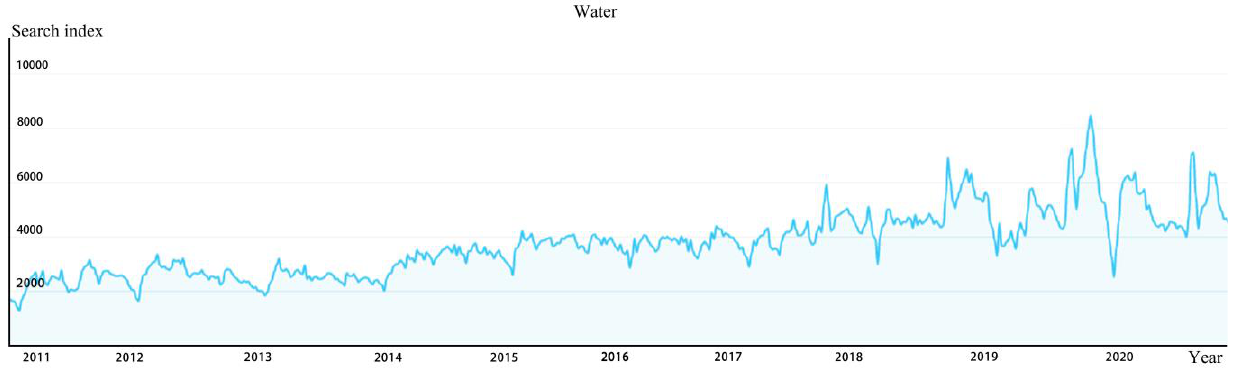
Figure 2. Baidu Index Trend of keyword “water”, 201 1 – 2020.